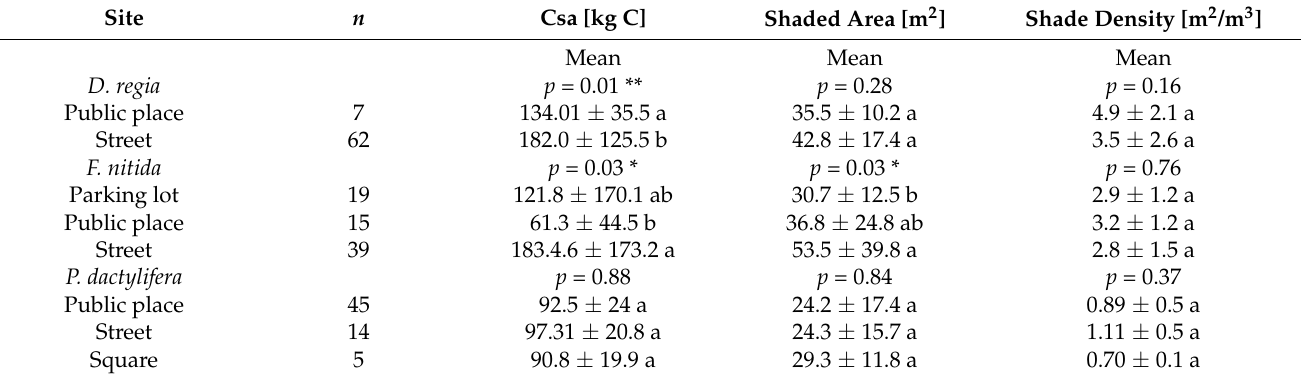
Table 7. Means and SD of the ecosystem services above-ground biomass carbon storage Csa, shaded area, and shade density for D. regia , F. nitida , and P. dactylifera in response to growth site, as well as the p -value (with levels of significance indicated by symbols such as ** and *)for each ANOVA. The mean values in the same column differ significantly when followed by different